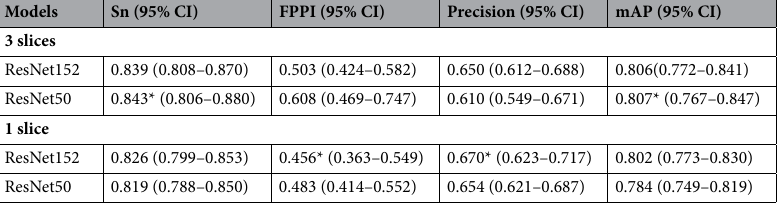
Table 1. The performance results from each model. CI confidence interval, Sn sensitivity, FPPI false positive per image, mAP mean average precision. *Highest values of comparison parameters.